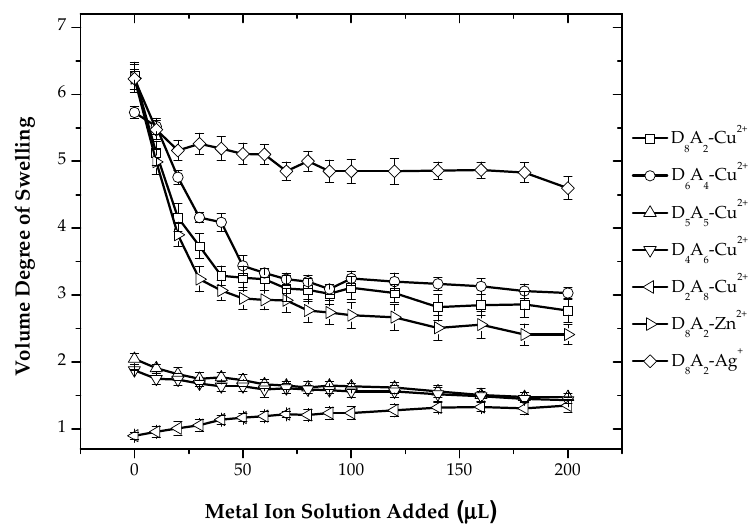
Figure 7. Variation of the volume degree of swelling with respect to varying amounts of CuSO 4 solution (0.01 M) for all compositions of hydrogels and variation of the volume degree of swelling of D 8 A 2 hydrogels with respect to the addition of different metal ions for System II. Polymers 2016 , 8 , 233